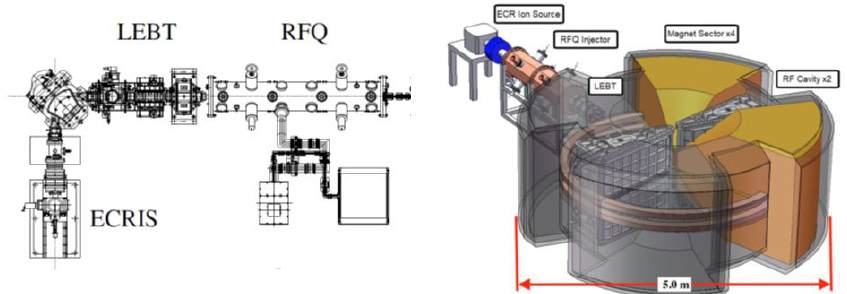
Figure 9. HIMAC, Japan ion source, and RFQ ( left ), which serve as the concept for the upstream pre-acceleration system for the injector accelerator ( right ). A CAD model of the full conceptual design of the 20 MeV/u injector system (scalable to 70–100 MeV/nucleon) is shown on the right. From left to right, the ECR ion source, focusing solenoid, RFQ, beam focusing quadrupoles, and the cyclotron shown with a transparent outer shielding for clarity.